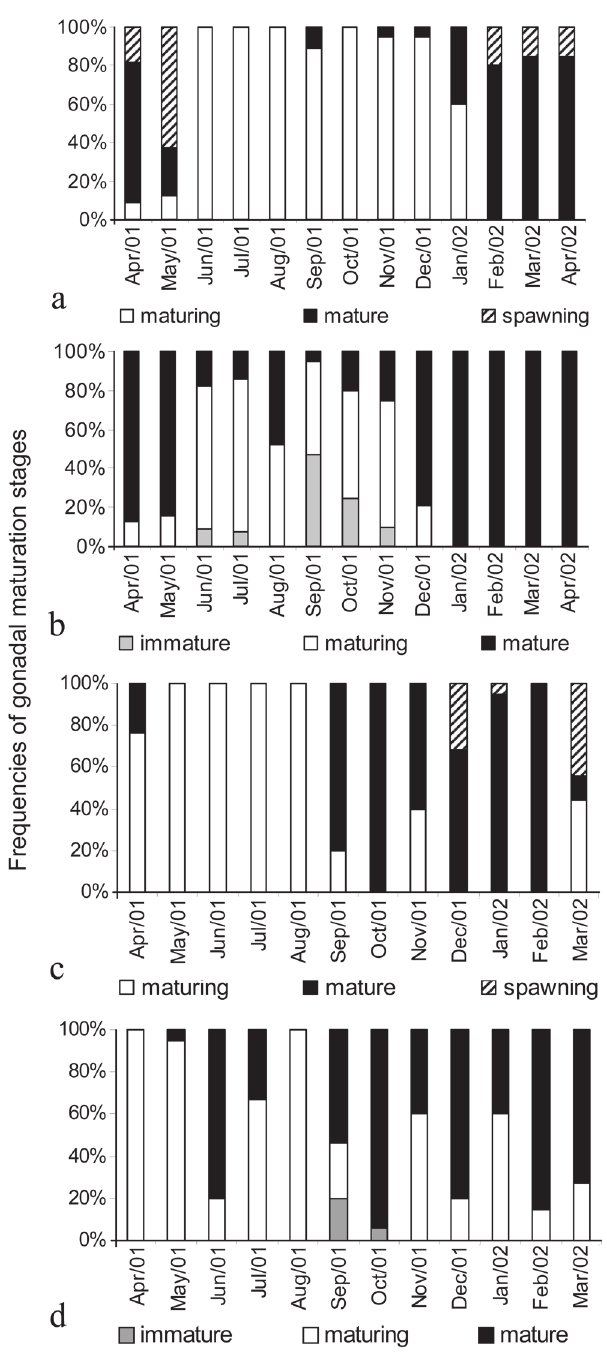
Fig. 5. Monthly distribution of the frequencies of gonadal maturation stages of females ( a ) and males ( b) of Compsura heterura and females ( c ) and males ( d ) of Odontostilbe pequira collected in the rio Ceará-Mirim, RN, and in the rio Ibicuí- Mirim, RS, from April 2001 to